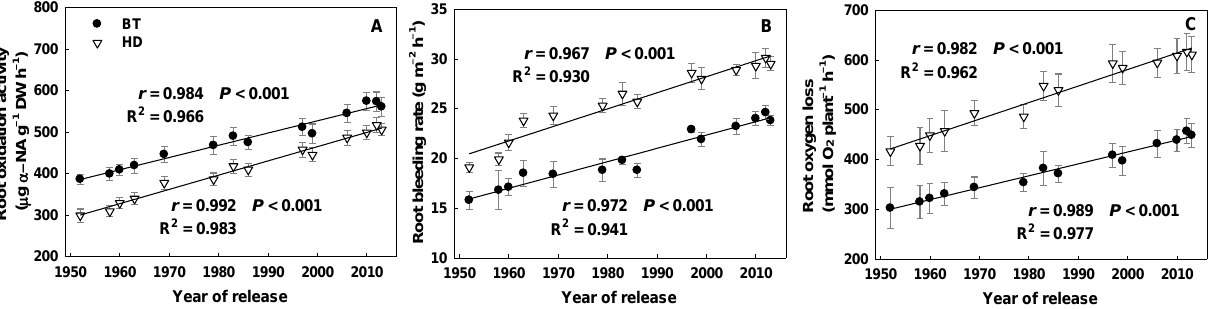
Figure 2. Changes in root oxidation activity ( A ), root bleeding rate ( B ), and root oxygen loss ( C ) during japonica rice cultivar renewal. BT: booting stage; HD: heading stage. Data are the mean value of two experimental years for each cultivar, and error bars indicate the standard errors of the mean. Solid lines indicate linear regression